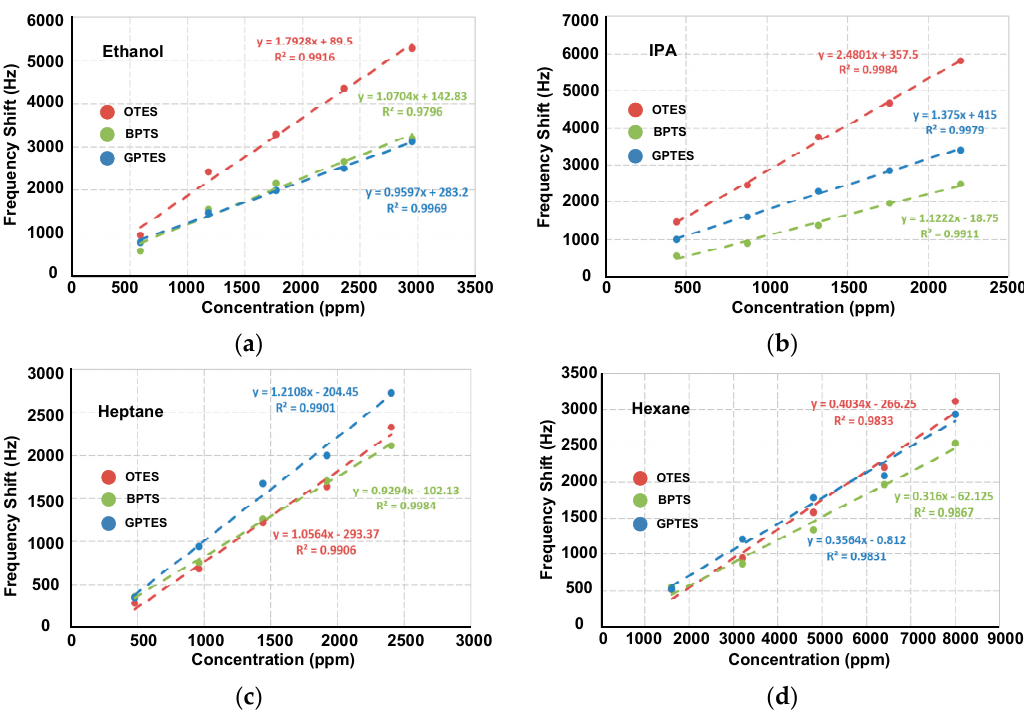
Figure 5. Linear fitting of sensitivities of three self-assembled monolayers (SAM)-modified PSBARs to ( a ) ethanol, ( b ) IPA, ( c ) heptane and ( d ) hexane. R 2 is the correlation coefficient.